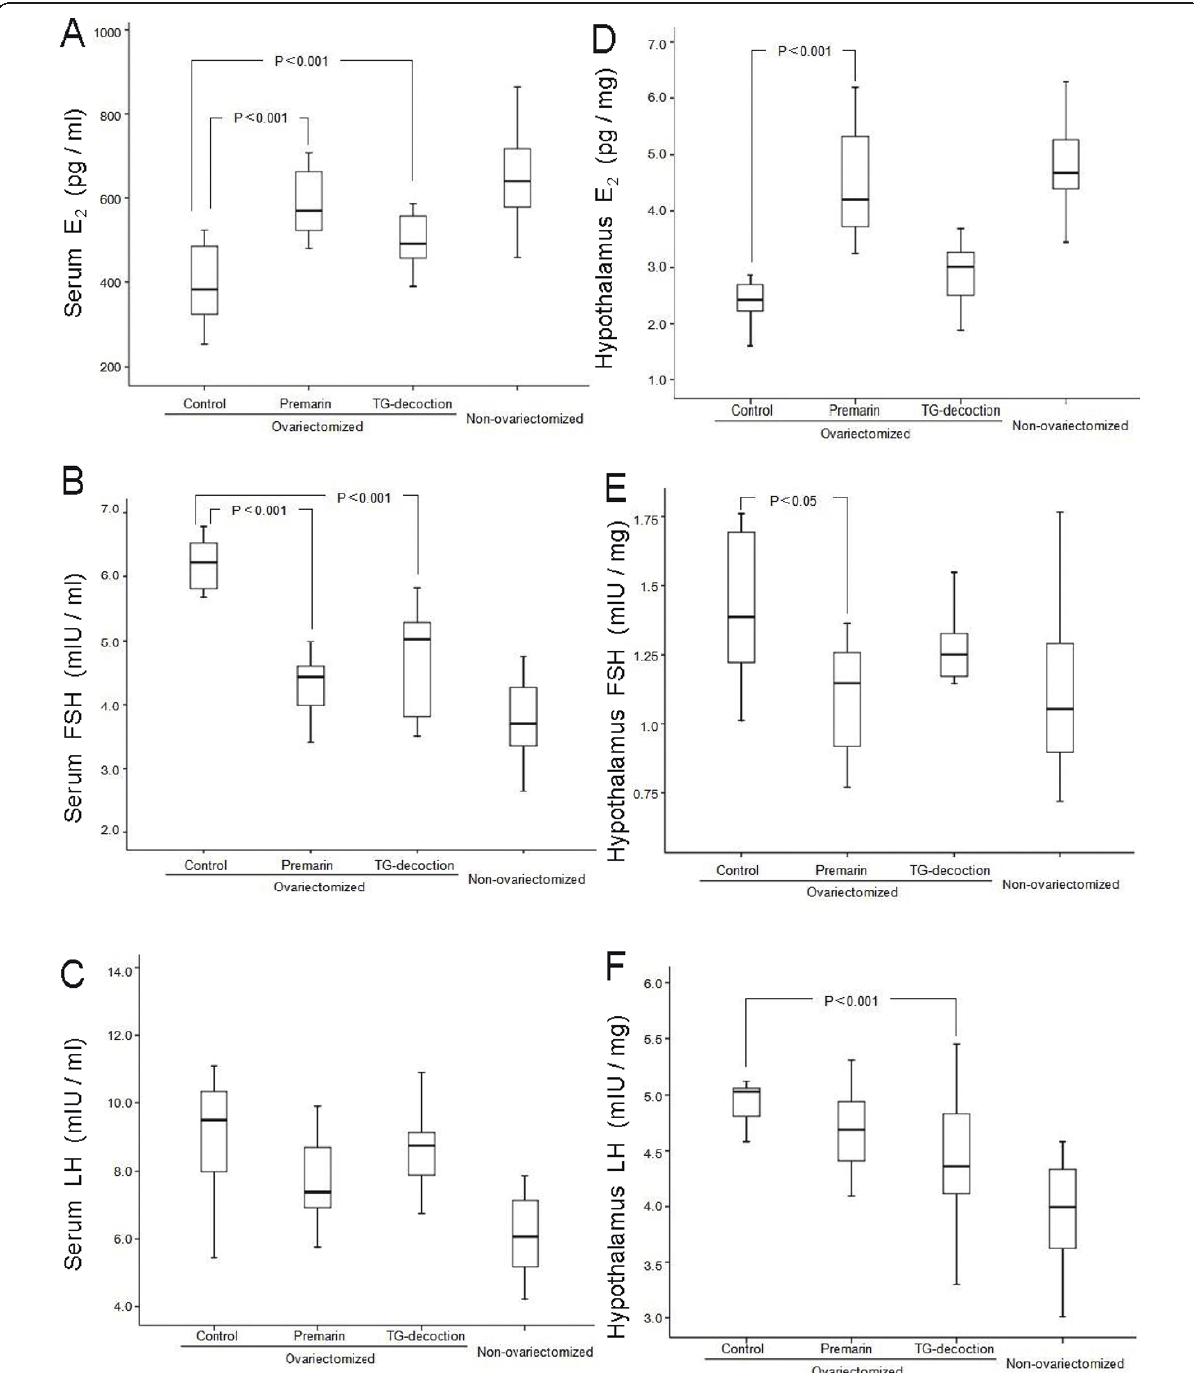
Figure 1 Sex hormones . Female hormones E 2 , FSH and LH in serum (A-C) and in the hypothalamus (D-F) in untreated (control), Premarin-treated and TG-decoction-treated ovariectomized rats, and in non-ovariectomized rats. Significance levels of differences are indicated in the